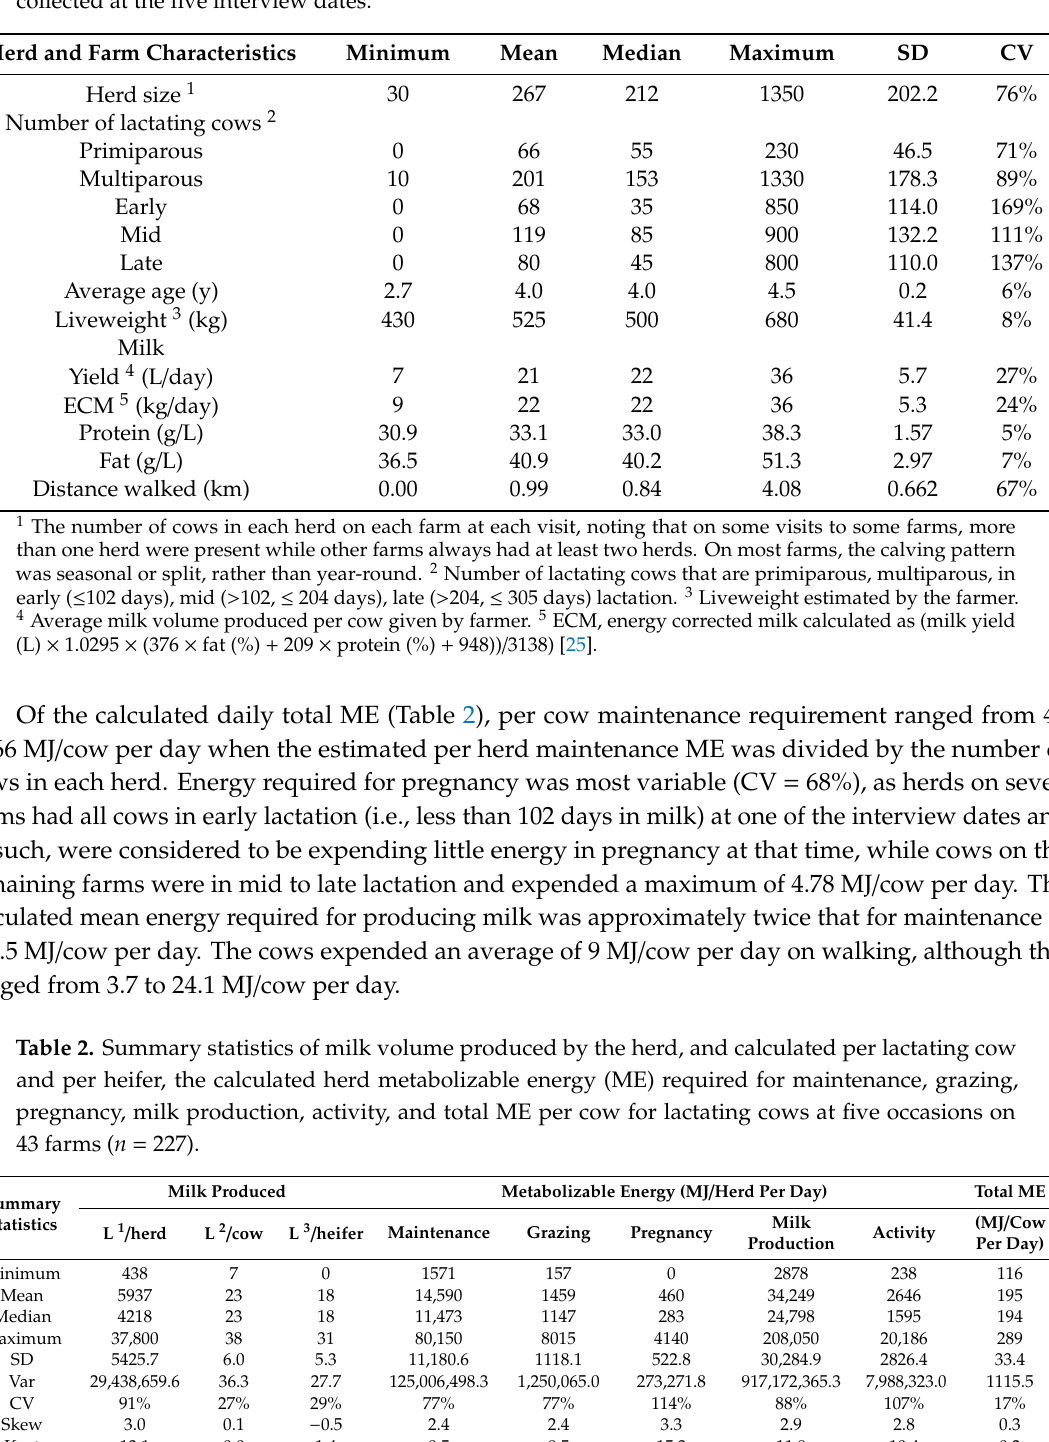
Table 1. Summary statistics for characteristics of milking herds and the 43 grazing system dairy farms collected at the five interview dates.